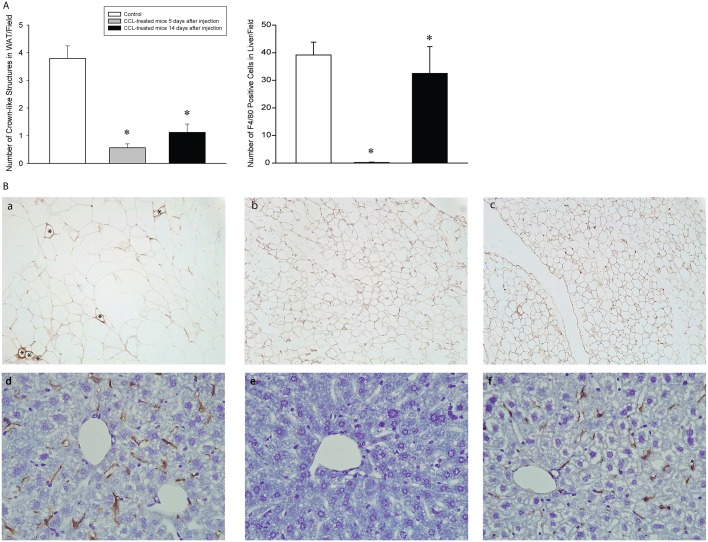
Intraperitoneal injection of clodronate-containing liposomes depletes macrophages in visceral white adipose tissue and liver in mice.A: the total number of crown-like structures/10 visual fields and the number of F4/80 positive cells/field in liver. Asterisks denote significant differences from control. B: Representative images of visceral white adipose tissues from control (a) and clodronate-containing liposome-treated mice 5 (b) and 14 days (c) after injections. F4/80 positive macrophages around adipocytes (crown-like structures) are indicated by asterisks. Representative images of liver from control (d) and clodronate-containing liposome-treated mice 5 (e) and 14 days (f) after injections.